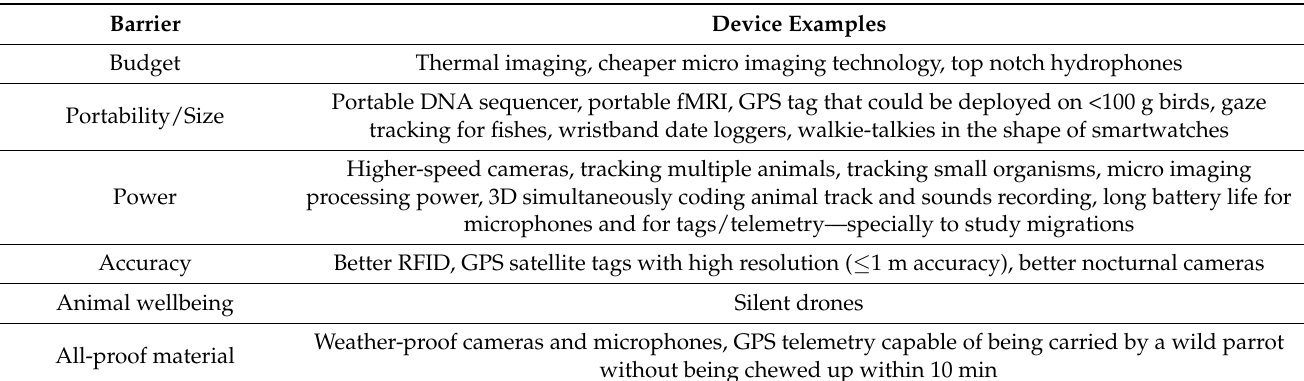
Table 3. Main barriers to currently dispose more adequate tech devices in Ethology. Device